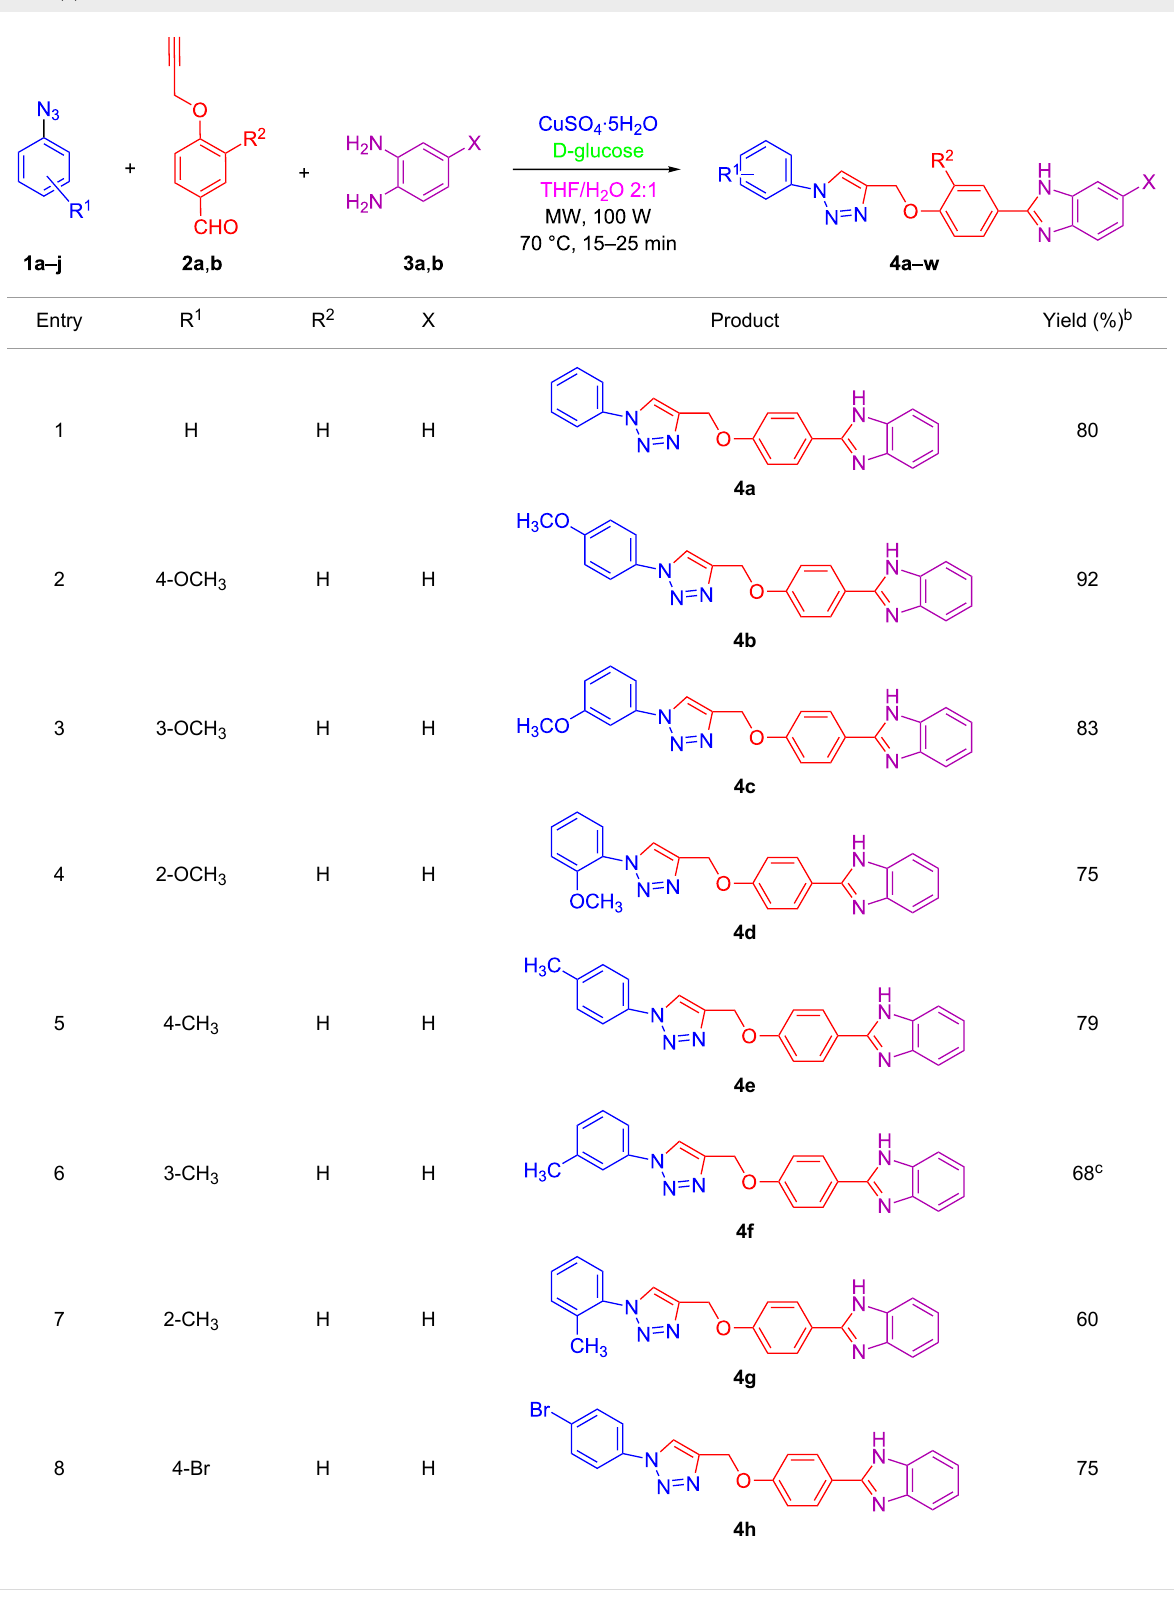
Table 2: Scope and limitations of the protocol employing different 4-(prop-2-yn-1-yloxy)benzaldehydes ( 2 ), phenylazides ( 1 ) and 1,2-diaminoben- zenes ( 3 ) a